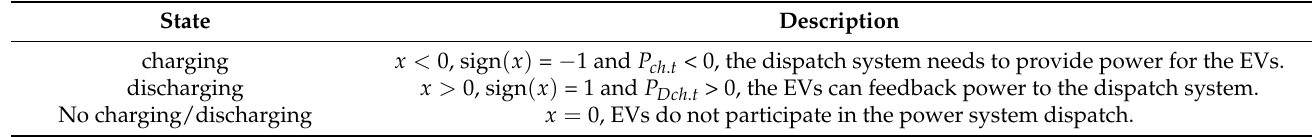
Table 2. The description of EV charging and discharging